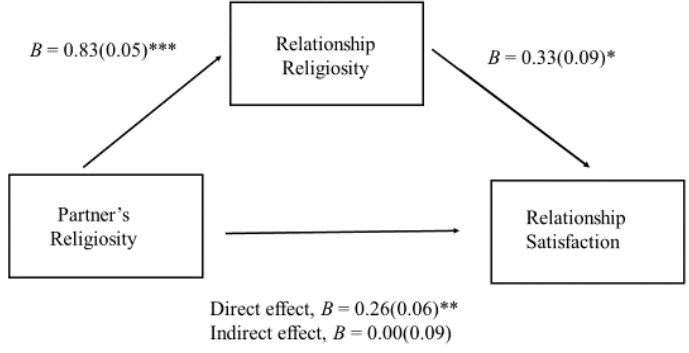
Figure 2. Mediation model for relationship religiosity and commitment.